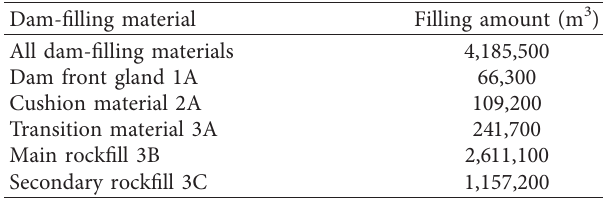
Figure 2: The overview of the Xujixia CFRD project. (a) The Xujixia CFRD. (b) The plan view of the Xujixia CFRD and locations of extensometers. (c) The cross section of the Xujixia CFRD and locations of extensometers. (d) The construction phases of Xujixia CFRD. Table 1: The filling amount of rockfill materials for the Xujixia Table 3: Mechanical properties tests of dam filling rockfill dam.